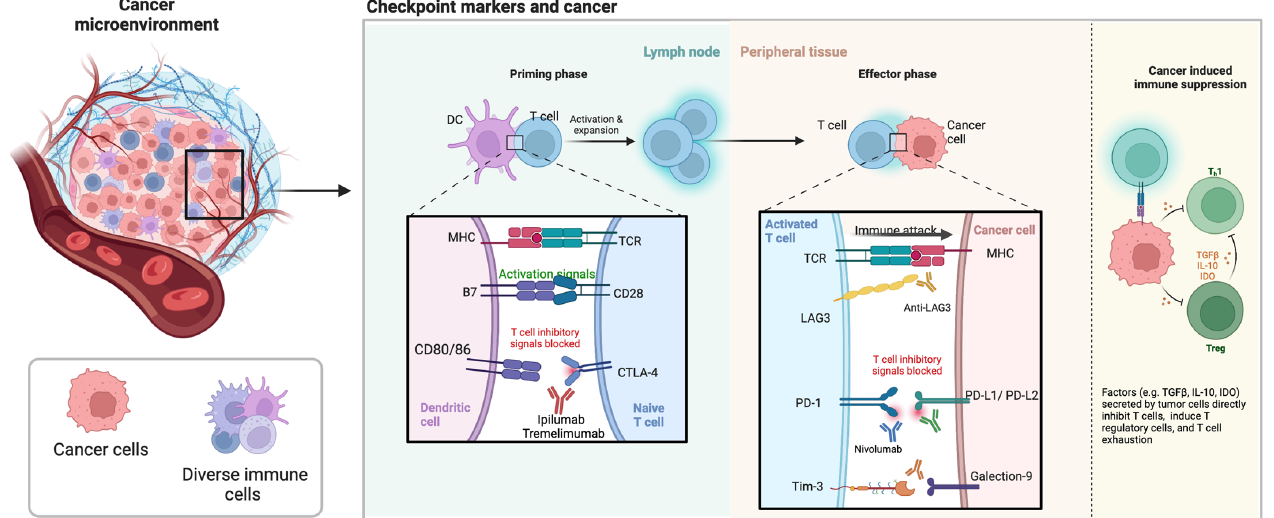
Figure 4. The cancer microenvironment is complex involving diverse immune cells and checkpoint markers. Figure reproduced from Ephraim et al [121] . CD, cluster of differentiation; CTLA-4, cyto-